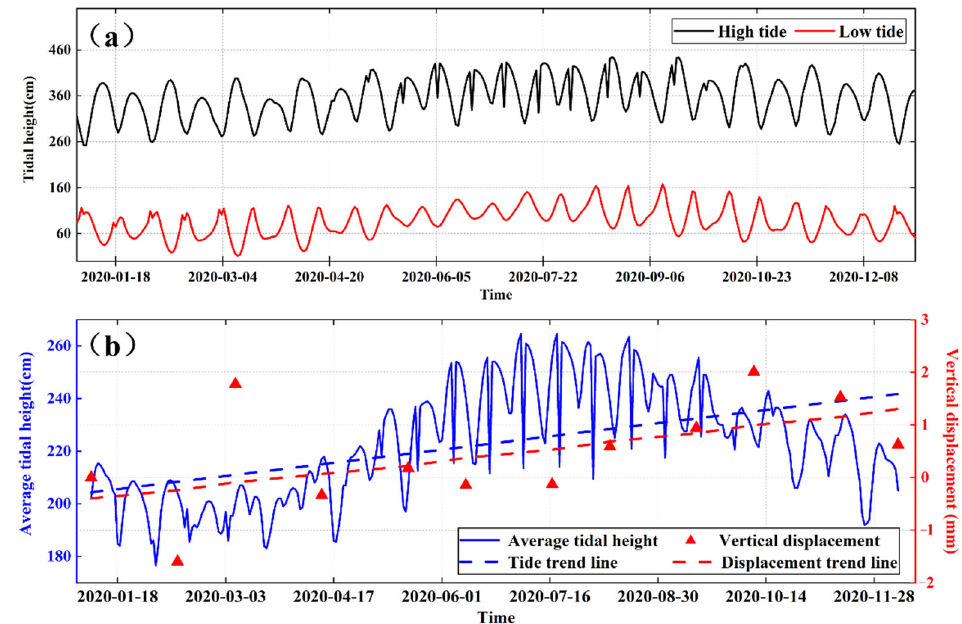
Figure 14. ( a ) Variation of daily high and low tide at Wuhaogou tidal station in 2020; ( b ) Comparison of average tide height and average cumulative subsidence at Wuhaogou tidal station.